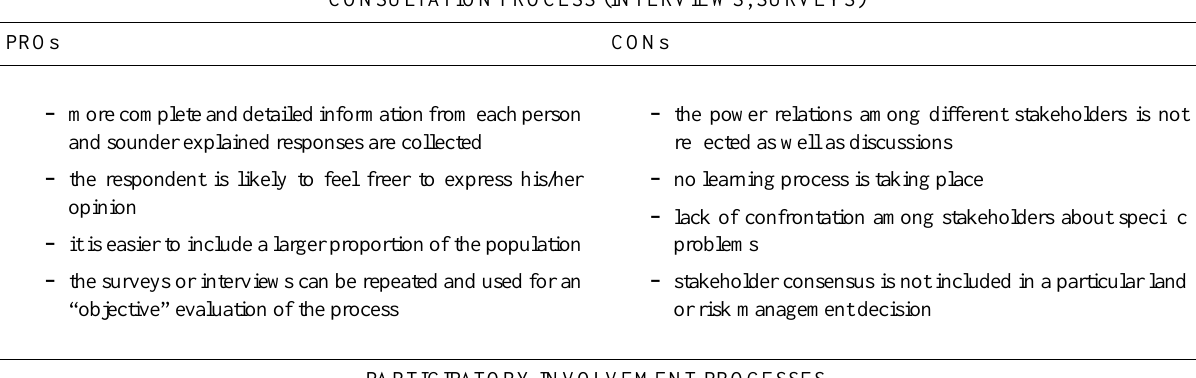
Table 1. Pros and cons of risk communication